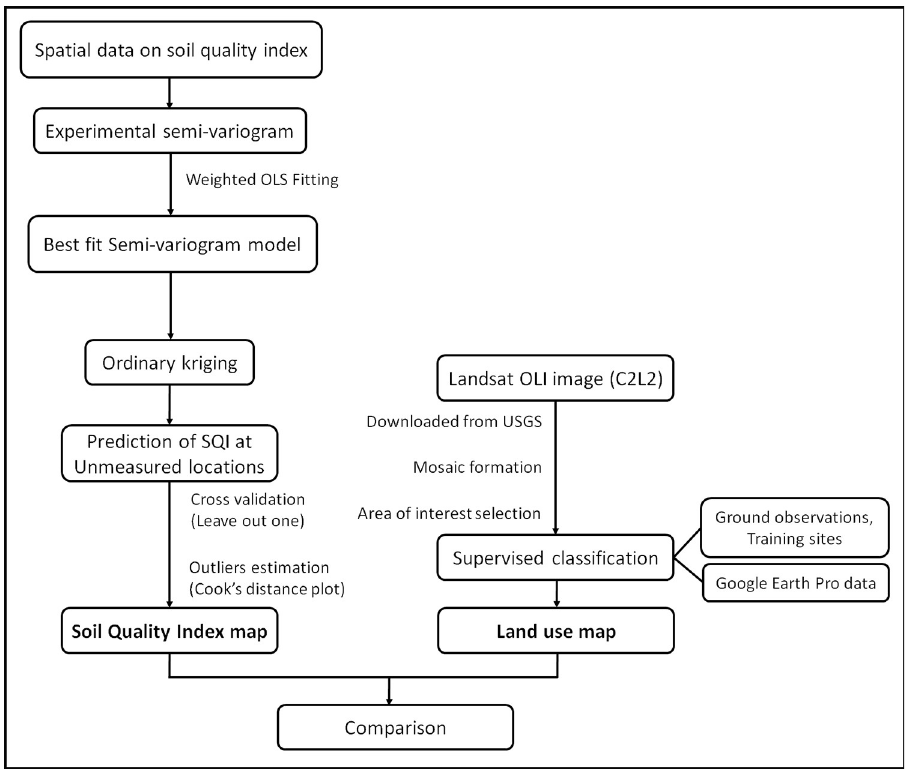
Fig 2. Flow-diagram explaining the process of mapping the soil quality index and land uses over the study area.